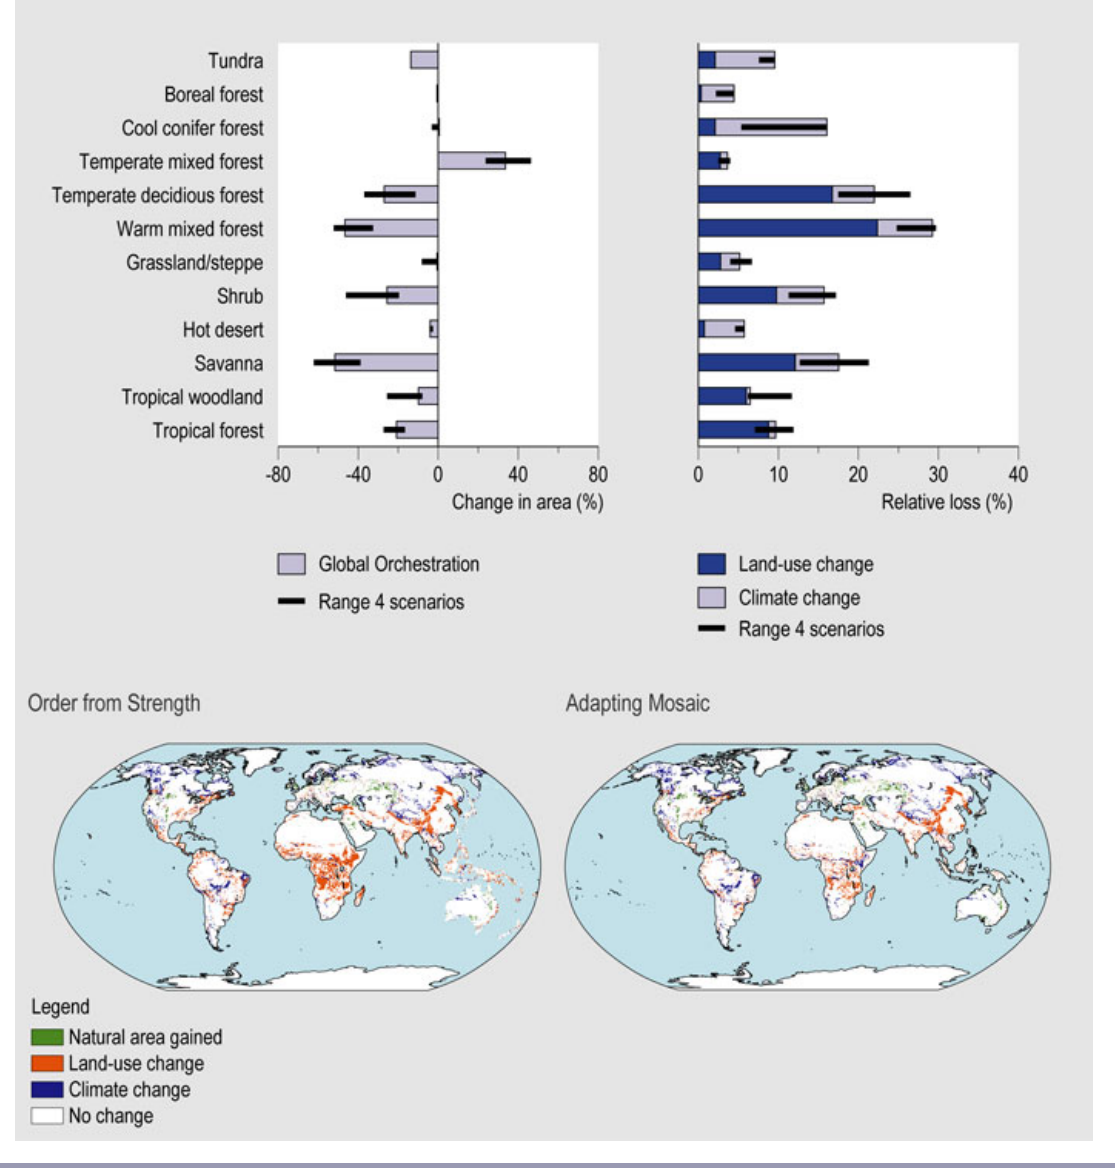
Fig. 4. Changes in 2050 in area of different biomes and vascular plant biodiversity in equilibrium with reduced habitat, relative to 1995. Top left panel shows the area of different biomes and top right panel vascular plant biodiversity at equilibrium, both for the Global Orchestration scenario. The uncertainty bars indicate the maximum and minimum values in the total set of scenarios. The bottom panels show changes in natural habitat extent due to land-use change and climate change at a resolution of 0.5° x 0.5°, for the two most extreme scenarios. Order from Strength, left and Adapting Mosaic, right. From "Ecosystems and Human Well-being: Scenarios, Volume 2" by Steve R. Carpenter, et al., eds. Copyright (c) 2005 Millennium Ecosystem Assessment. Reproduced by permission of Island Press, Washington,